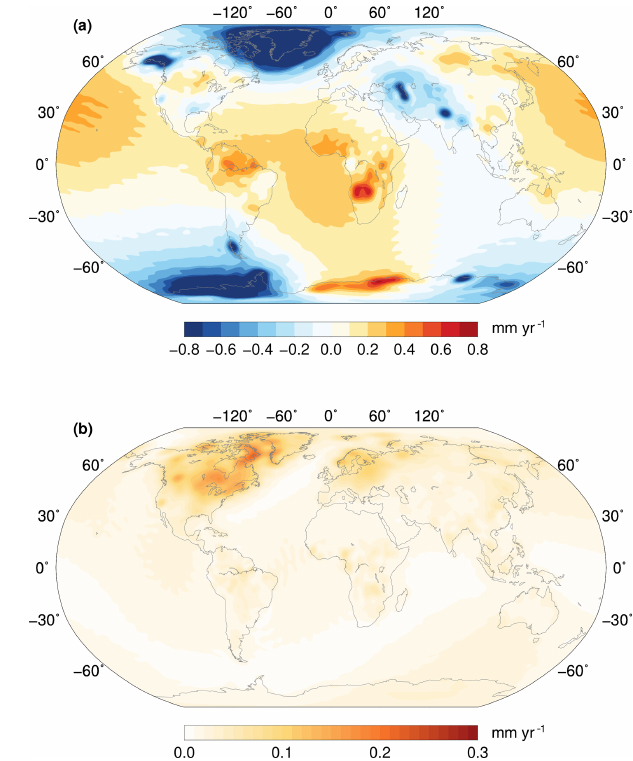
Figure 2. Ensemble solution for the effect of mass redistribution in the water layer (a) and 1 standard deviation (b) in terms of geoid height